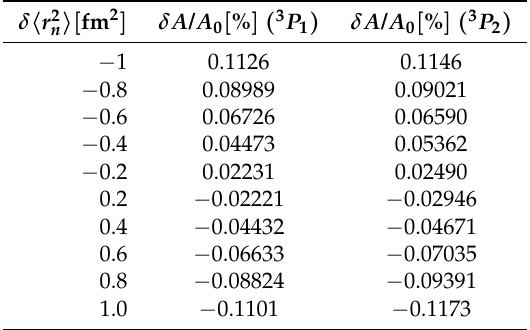
Table 6. Relative change in the hyperfine structure constant δ A / A 0 with variation in the mean squared radius of the nuclear charge distribution δ (cid:104) r 2 n (cid:105) from the reference nucleus with hyperfine structure constant A 0 in the electronic states 3 P 1 and 3 P 2 with the largest expansions.